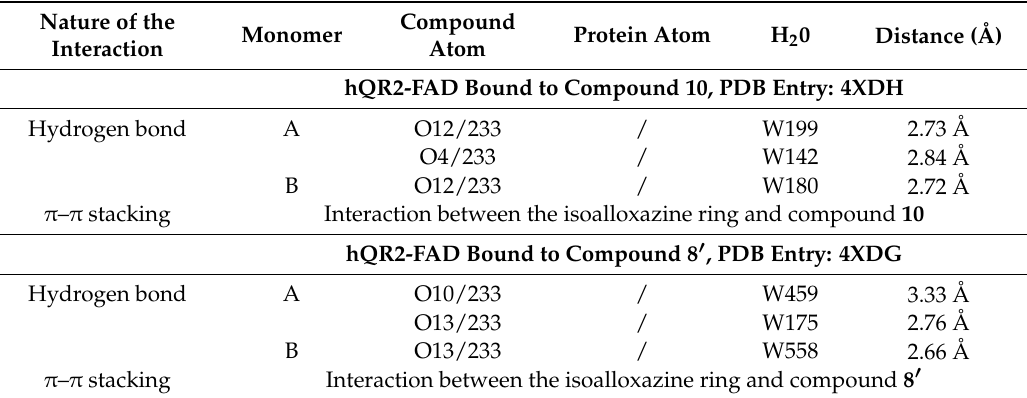
Table 2. Interactions established by compounds 8 (cid:48) and 10 in the human quinone reductase 2 flavin adenine dinucleotide (FAD) binding